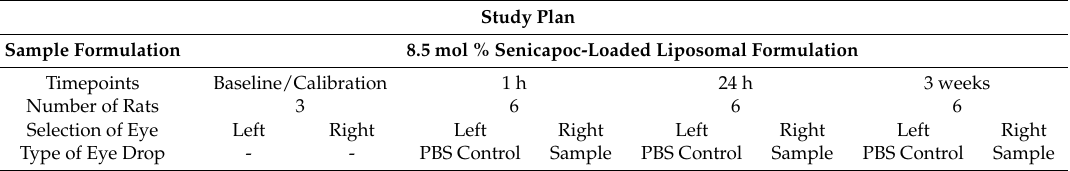
Table 1. Study Plan for in vivo PK study of Sub-conjunctiva